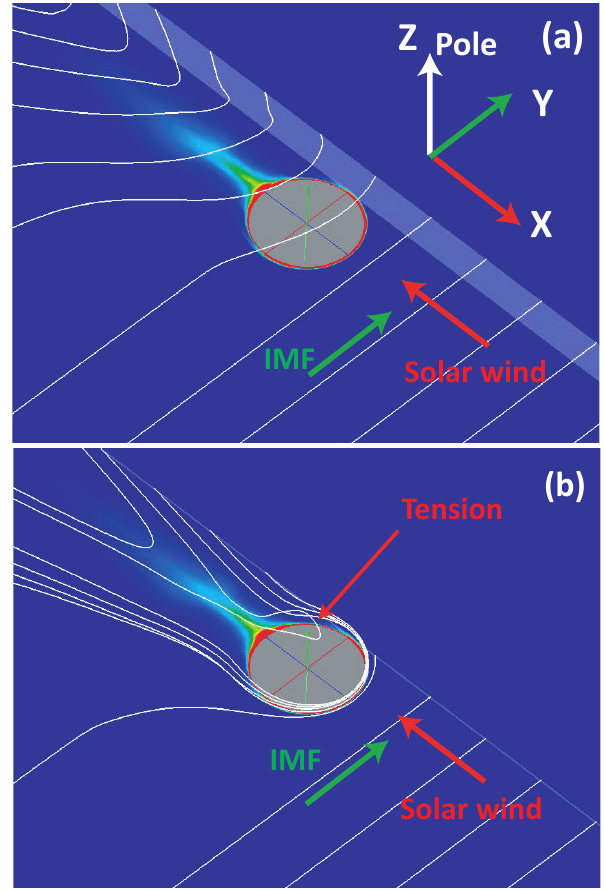
Fig. 2. The distribution of O + density is shown by color contours, 2 and the three-dimensional configuration of magnetic field lines is shown by white lines. The direction of the solar wind flow is toward − x direction. The IMF is directed in the + y direction and the z axis completes the right-handed coordinate system.The field line in panel (a) is at z = 1 R M initially. The field line in panel (b) is at z = 0 . 1 R M